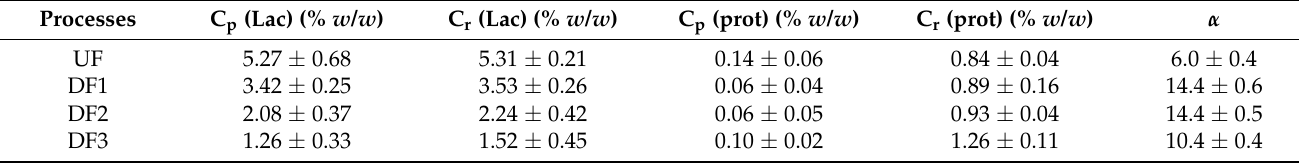
Table 4. Separation factors (1) ( α ) between lactose and protein, along with UF/DF processes for membrane RC70PP. Processes C p (Lac) (% w/w )